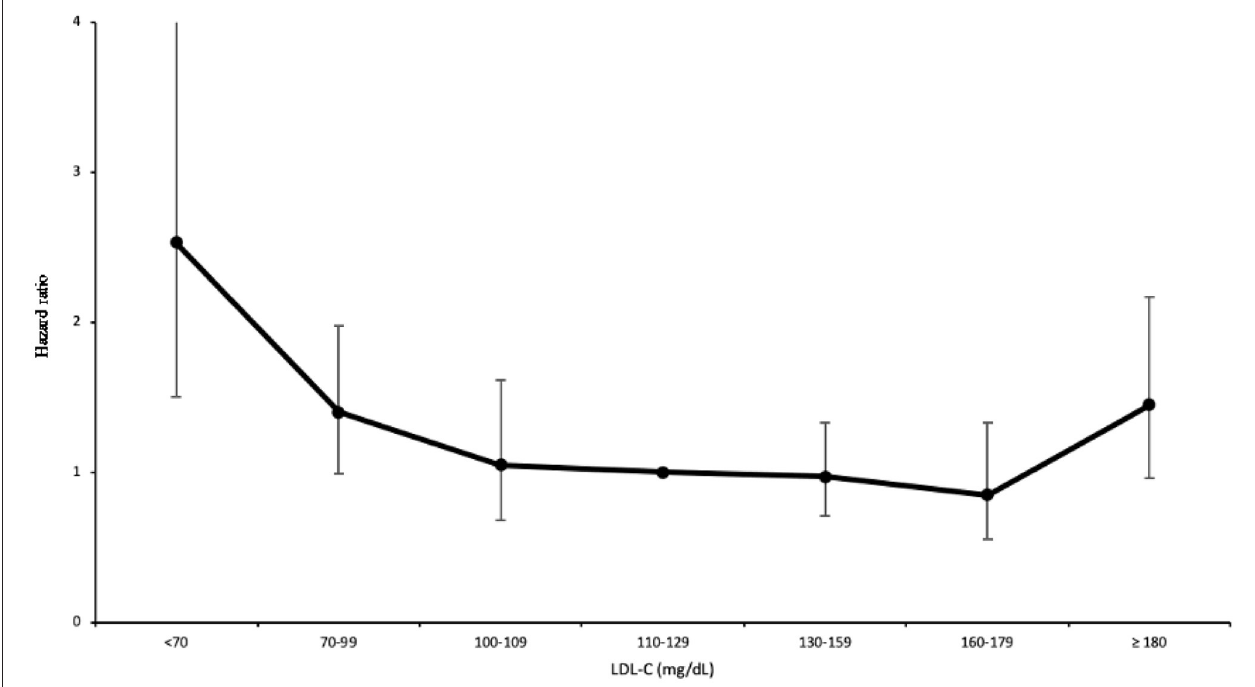
FIGURE 1 | LDL-C and hazard ratios for mortality from ICH in MJ